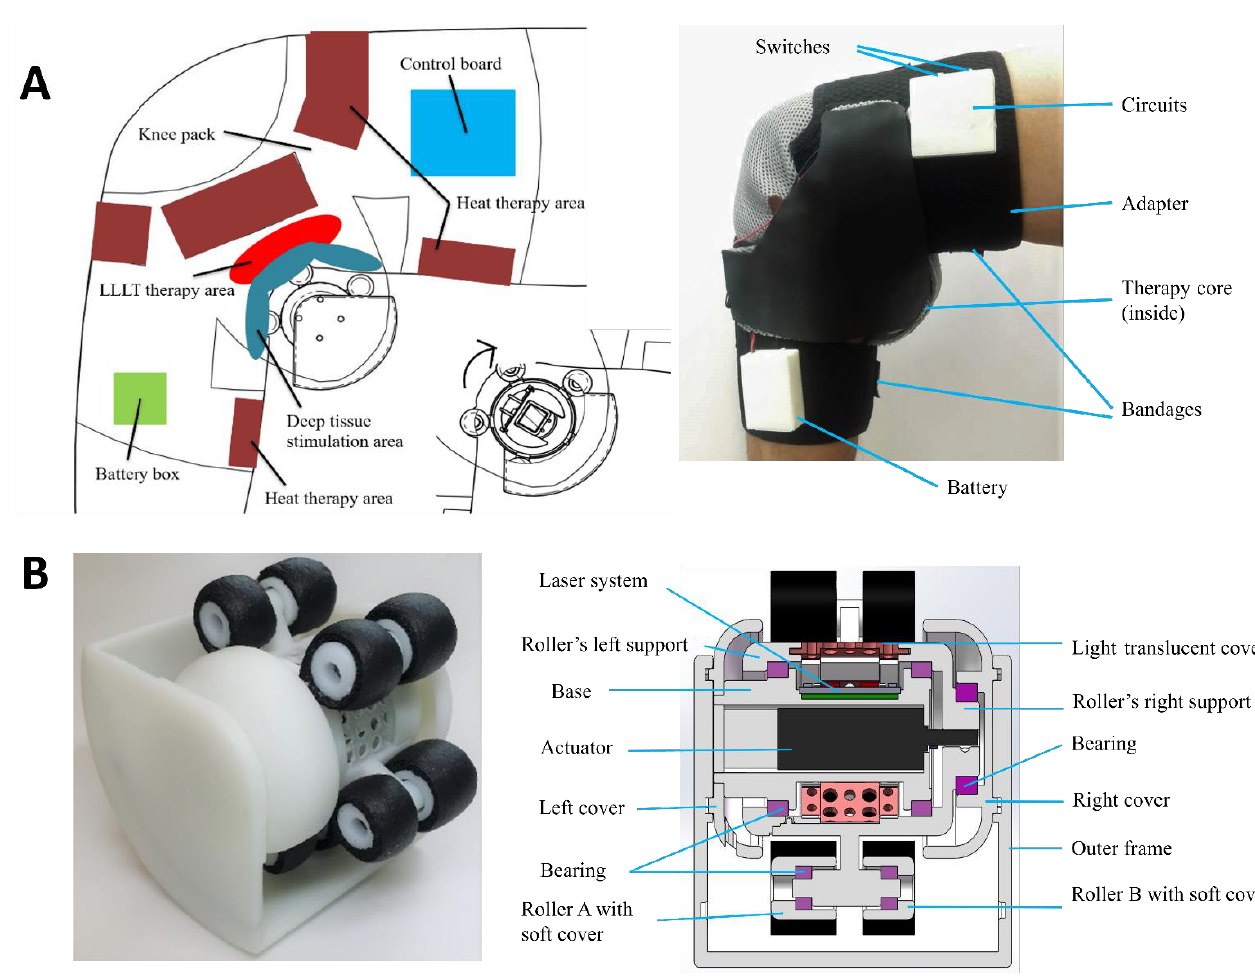
Figure 2. Device design and development: ( A ) Overview of treatment locations and a novel combination therapeutic device CUHK-OA-M2; ( B ) Core treatment components of the device: massage roller, laser emitter, and heat producer.